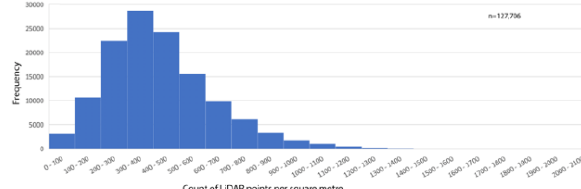
Figure 8: Frequency by number of LiDAR points/m 2 . The voxel analyses are performed with in-house J-based software. J is a powerful general-purpose array-based language that is suitable to develop algorithms for exploring problems with matrices and higher dimensional arrays. J is suitable for this study as a voxel space is a typical example of large array. Alongside J, Cloud Compare is used to visually inspect the pointcloud data.